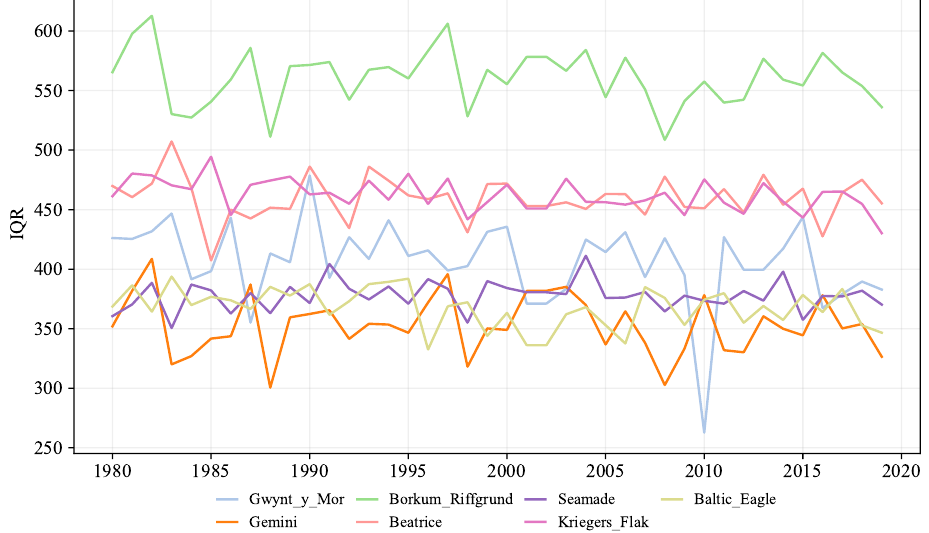
Figure A4. Interquartile range of selected wind farms from 1980 to 2019. Every line illustrates the yearly interquartile range (IQR) of one wind